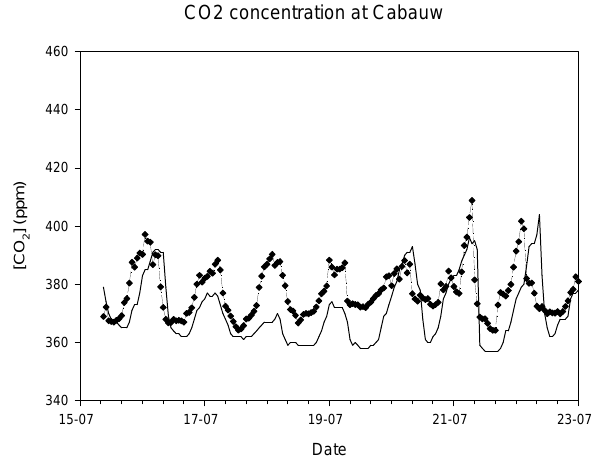
Fig. 15. Comparison of observed and simulated [CO 2 ] (ppm) at 60m for Cabauw. Diamonds and dashed lines: observed values; black lines simulated at a grid point nearest to the observational site.